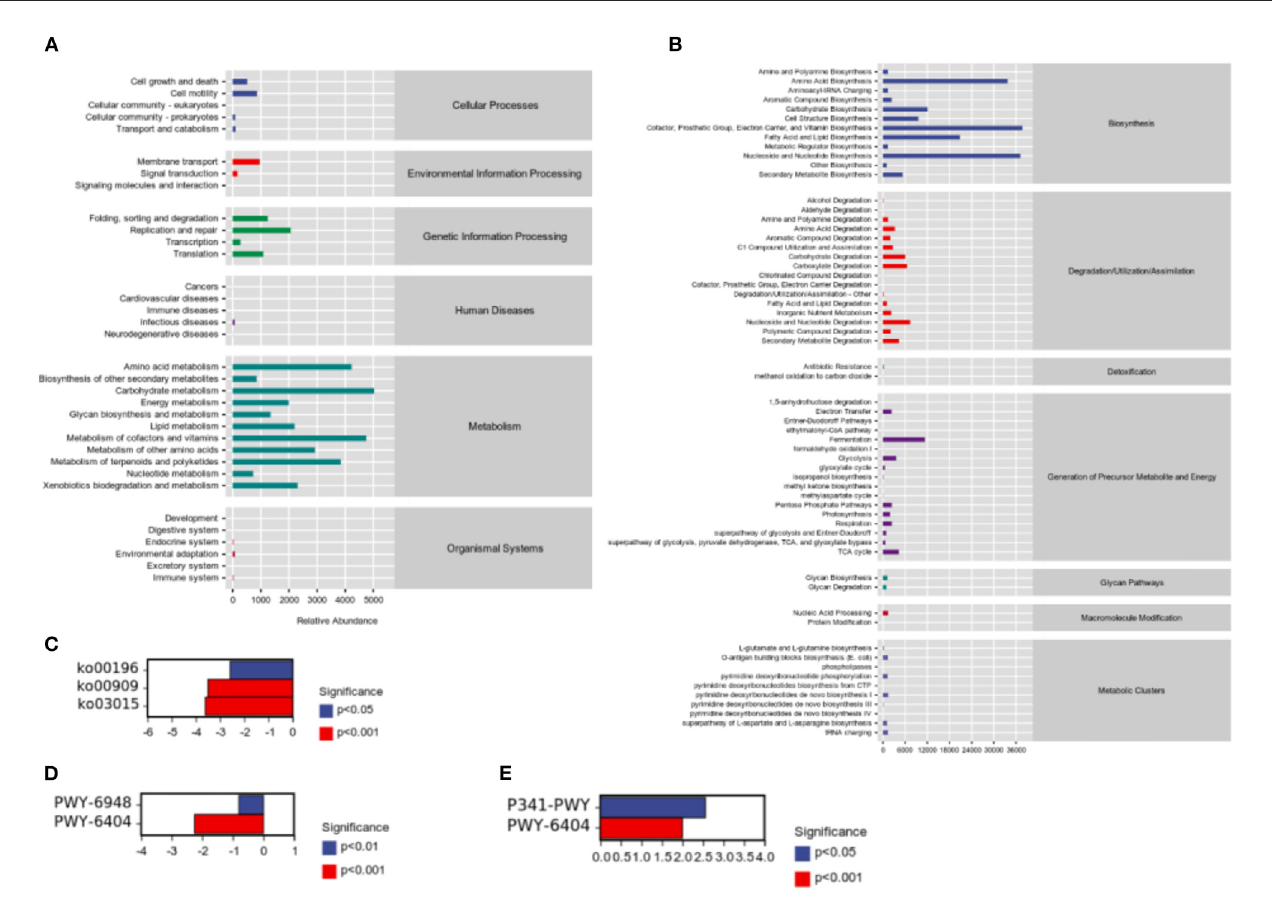
FIGURE6 Sample functional abundances predicted by PICRUSt2 based on the abundance of labeled gene sequences in the samples. (A) KEGG databases. (B) Metacyc databases. (C) Significant pathway analysis between H and HP groups based on KEGG databases. (D) Significant pathway analysis between C and H groups based on Metacyc databases. (E) Significant pathway analysis between H and HP groups based on Metacyc databases.